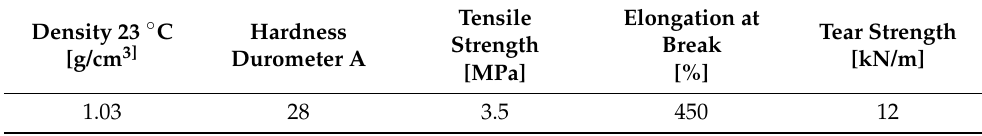
Table 3. Two-component silicone rubber KE-1603-A after-curing